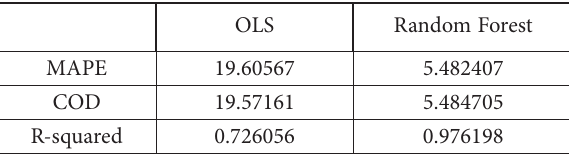
Table 5. Measurements for accuracy (average of 10